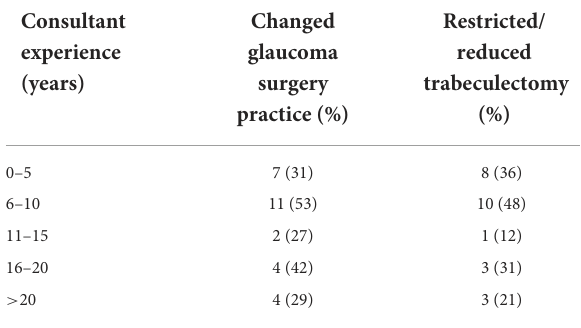
TABLE 1 Patterns of change in glaucoma surgery practice according to consultant experience